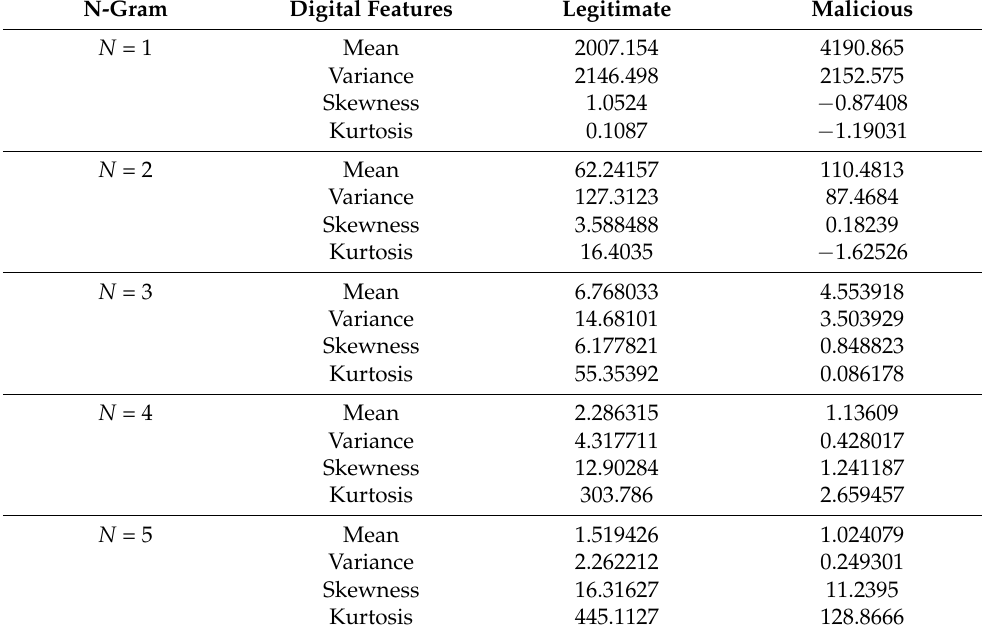
Table 3. N-gram algorithm results analysis. The mean value is an indicator of the concentration trend of the distribution of the phrase elements; the variance shows the trend of the number of phrase elements; the skewness shows whether the distribution of the phrase elements of the domain name is symmetrical; the kurtosis can get the difference of the data distribution of the domain name phrase elements data compared with the normal distribution. N-Gram Digital